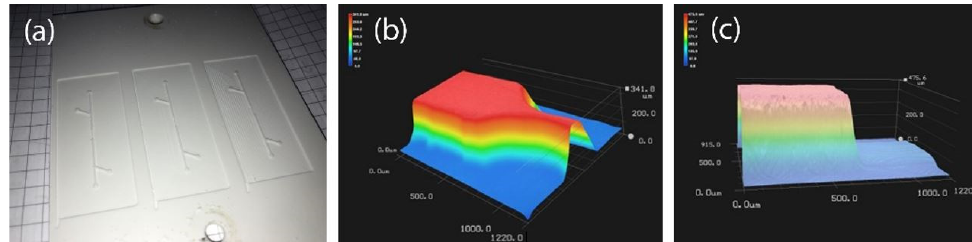
Figure 18. ABS casting molds fabricated with a milling machine. ( a ) Different offsets of 0.1 mm, 0.4 mm, and 0.7 mm from left to right. ( b ) Narrow sieve 3D picture. ( c ) Flat sieve 3D picture taken from the casting mold at the transition of the lower to the higher channel structure.